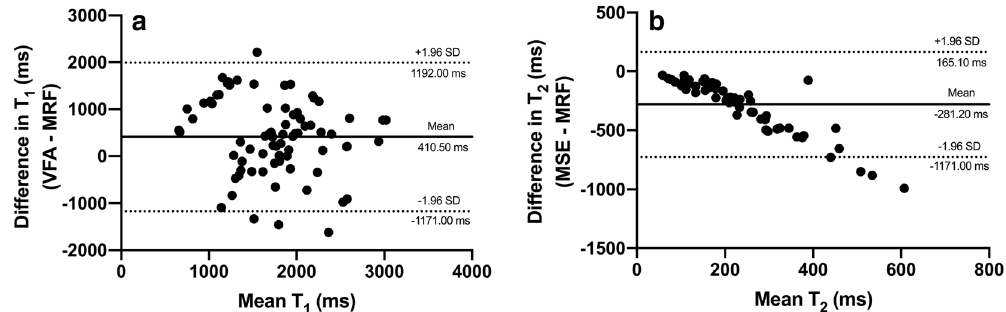
Figure 2. Bland–Altman plots comparing pre-GBCA in vivo MRF and VFA T 1 values ( a ) and MRF and MSE T 2 values ( b ) obtained from all tissues included in the analysis. Dotted lines represent upper and lower 95% limits of agreement and bold lines represent the mean biases with appropriate captions included. MRF magnetic resonance fingerprinting, VFA variable flip angle, MSE multiple spin echo.